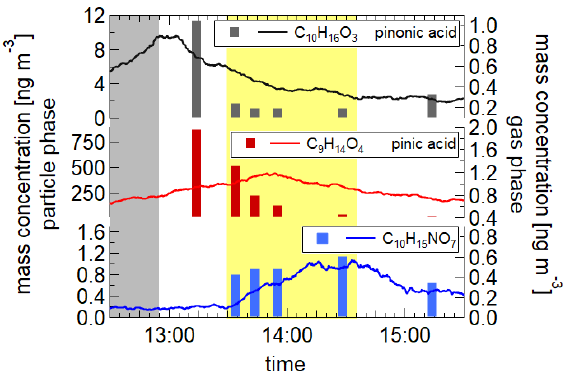
Figure 10. Mass concentration of pinic and pinonic acid as well as one of the identified products. Bars: particle phase; line: gas phase; grey shading: introduction of aerosol into the AIDA chamber; yel- low: illumination period. Pinic and pinonic acid reduces during il- lumination, while the product C 10 H 15 NO 7 increases. Due to its in- stable peroxy structure, the product concentration declines after the end of the